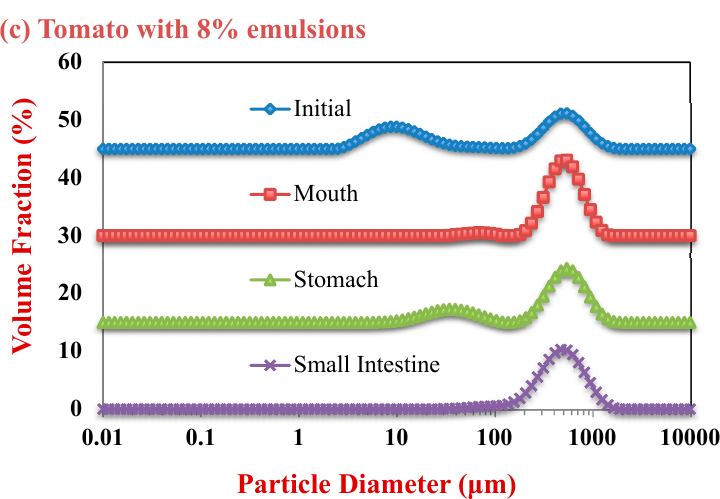
Figure 2. Particle size distributions of samples with different lipid contents as they were exposed to simulated gastrointestinal tract (GIT) conditions: (a) tomato with 0% emulsions; (b) tomato with 4% emulsions; and, (c) tomato with 8% emulsions.